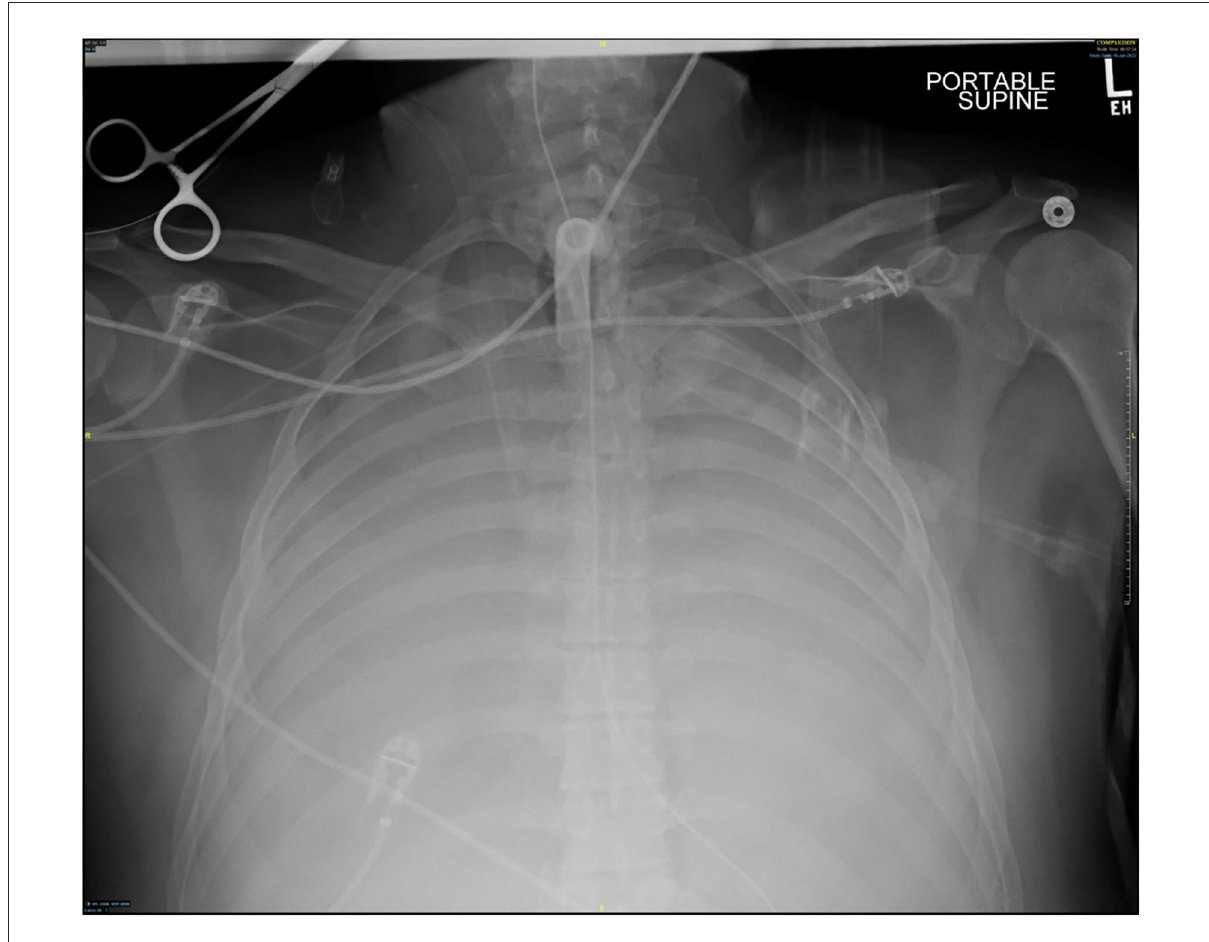
FIGURE1 Chest x-ray at the time of